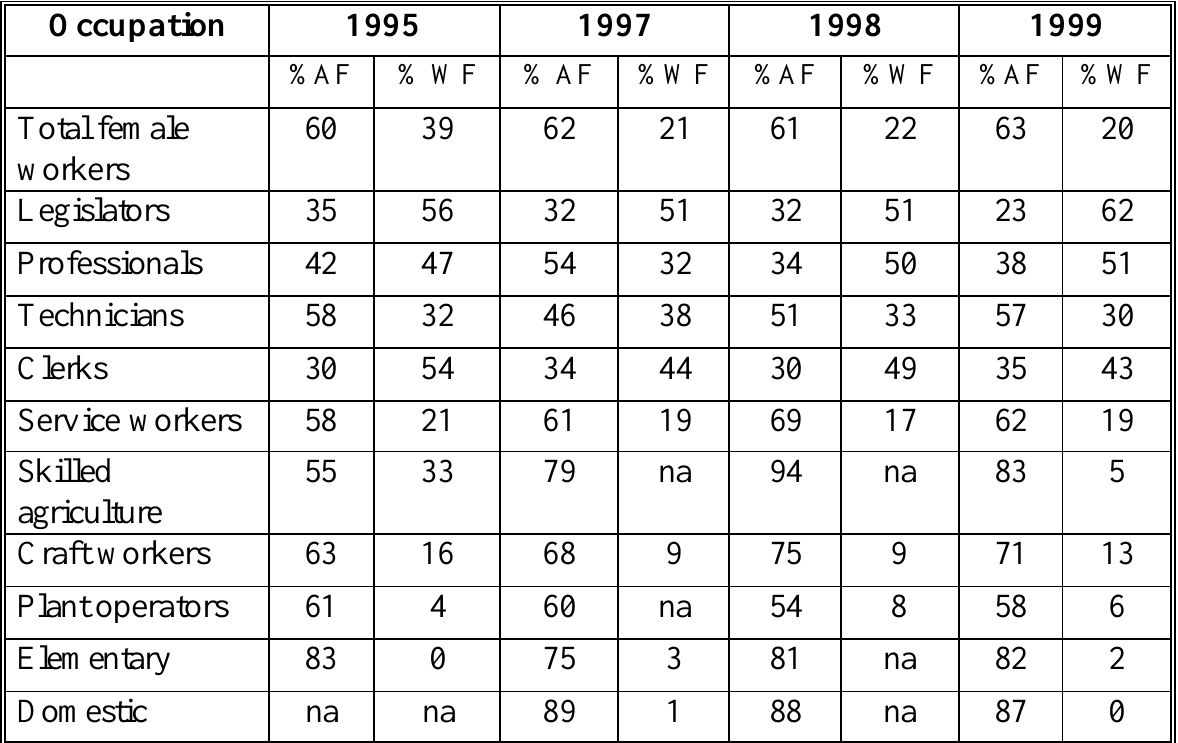
Table 2 Distribution of African and White female workers